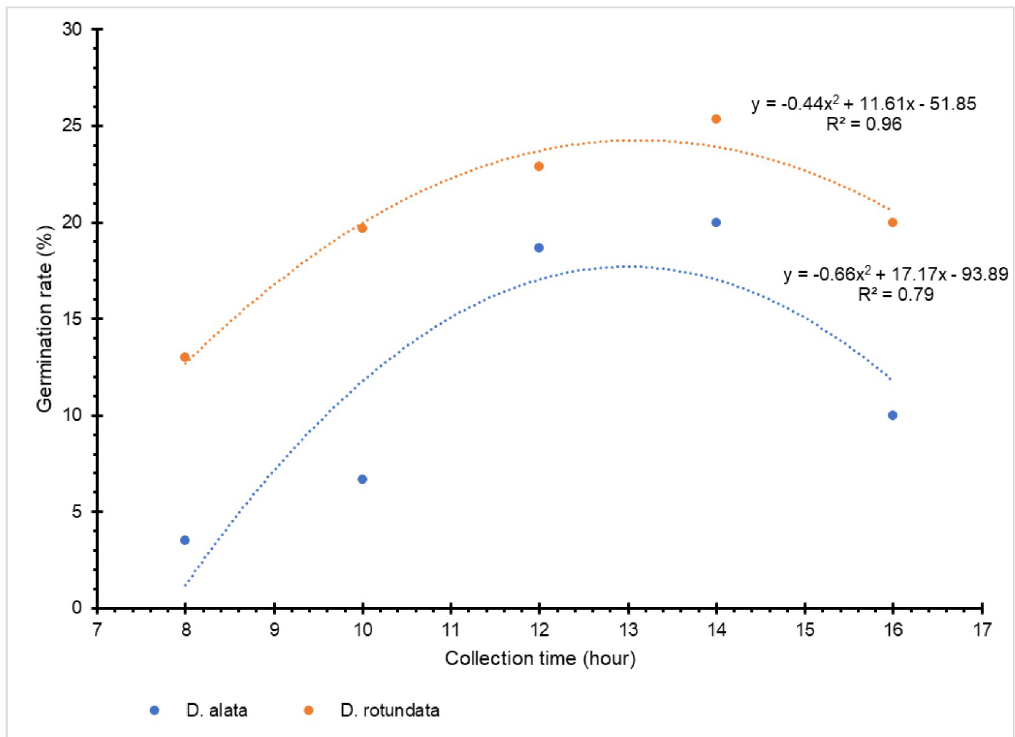
Fig 4. Dynamics of pollen germination rates across day